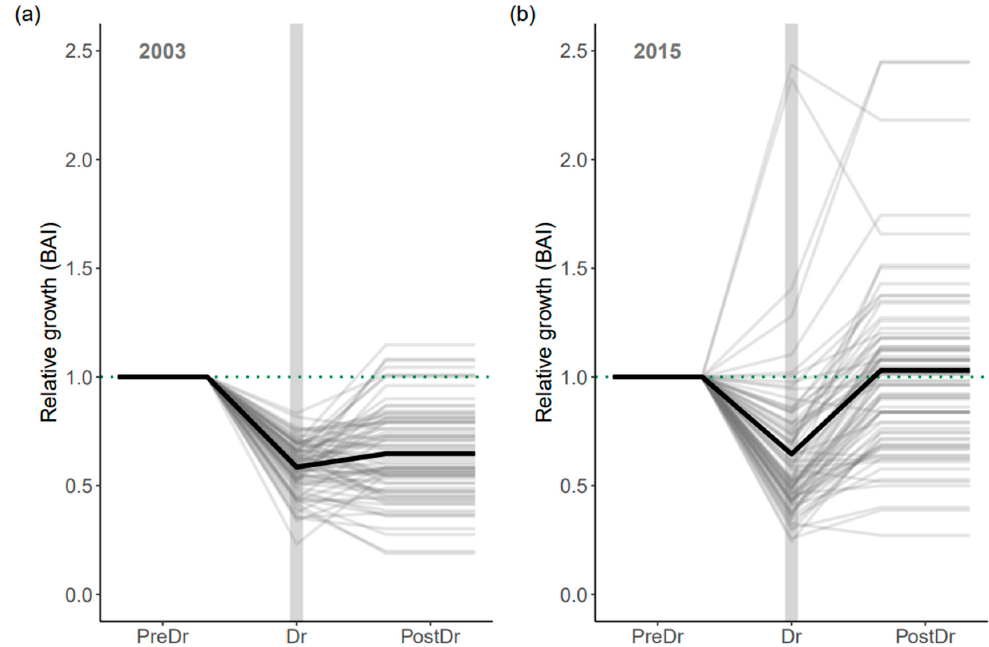
Figure 5. Growth responses of N. spruce to droughts in 2003 ( a ) and 2015 ( b ). Each gray line represents the relative growth course of the spruce trees in a two-year period before the drought (PreDr; considered as a reference line = 1.0), during the drought (Dr), and a two-year period afterwards (PostDr). The bold black line shows the average growth response of all trees for the respective drought event. The vertical gray line highlights the drought event, whereas the dotted green line delineates a reference line based on the growth in the pre-drought period.